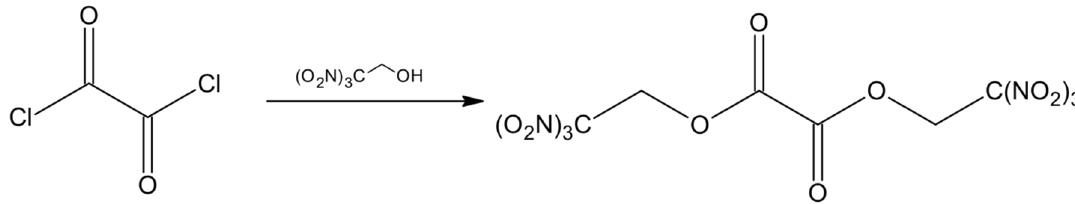
Figure 8. Synthesis of BTNEOx.